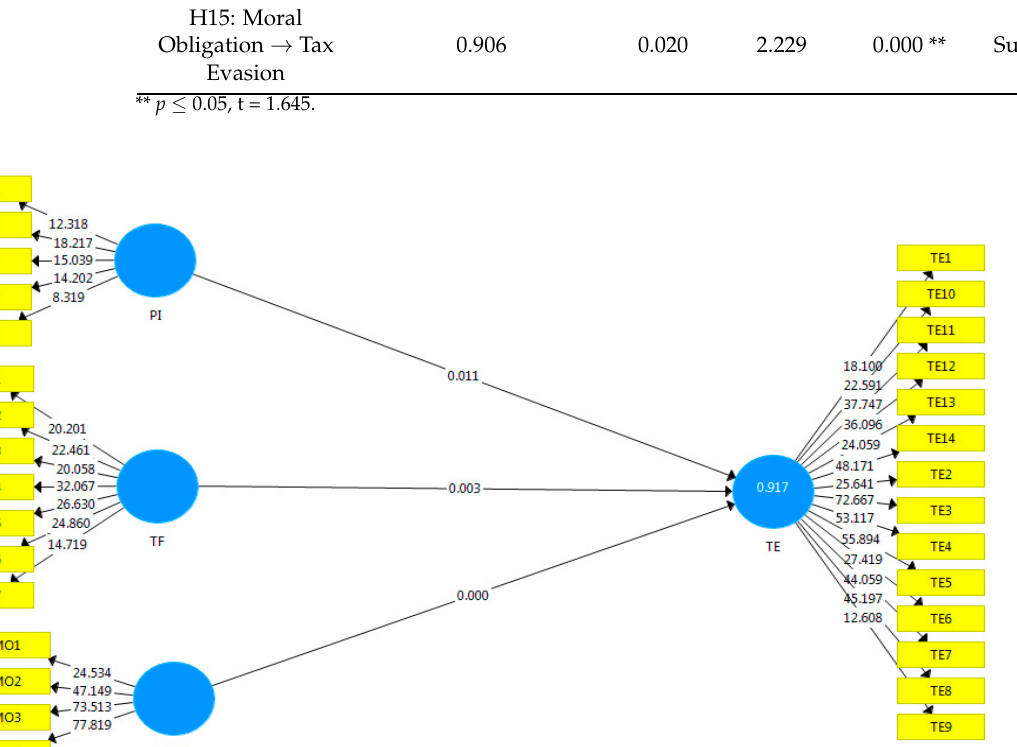
Table 5. Coefficient of determination, R².